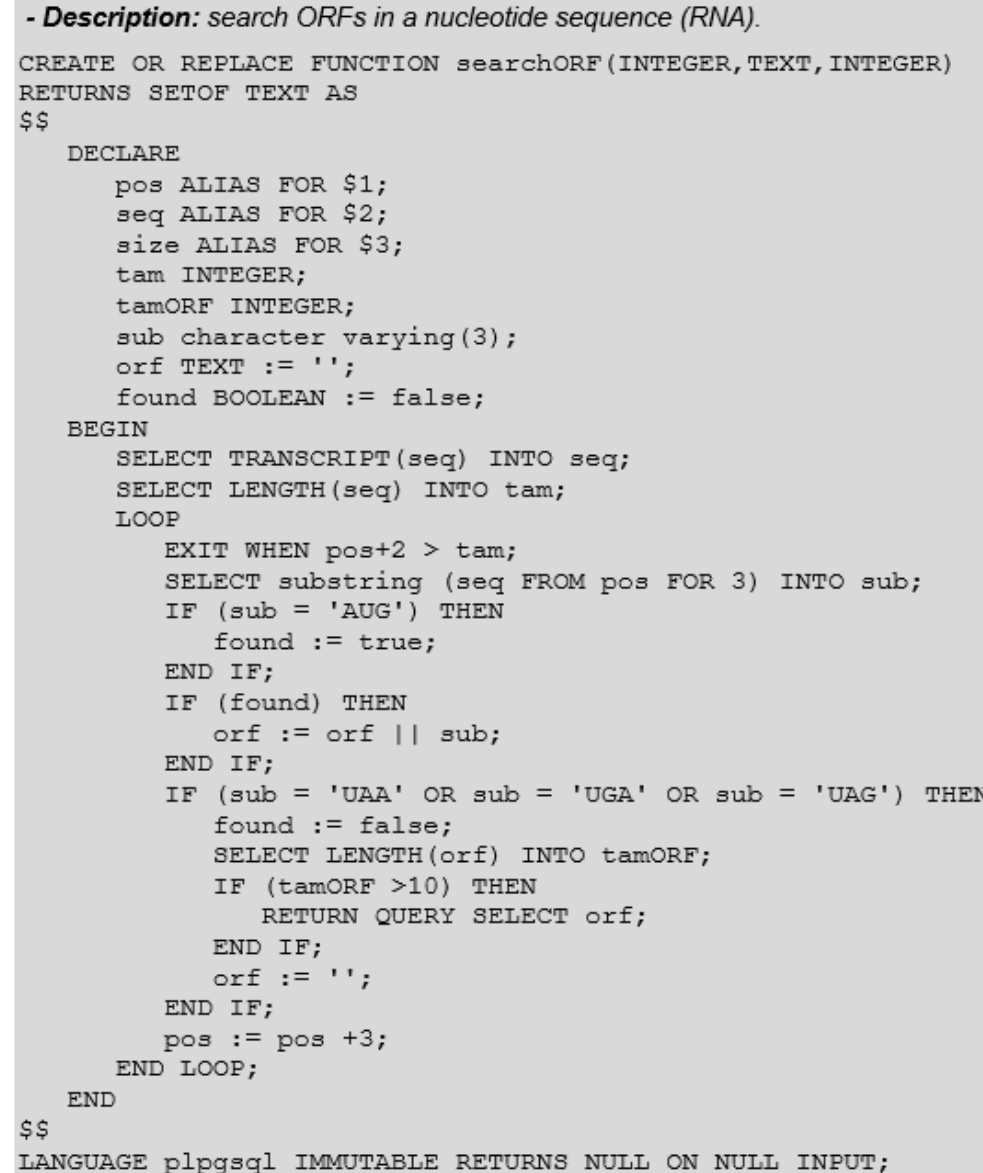
Figure 7. Search ORF